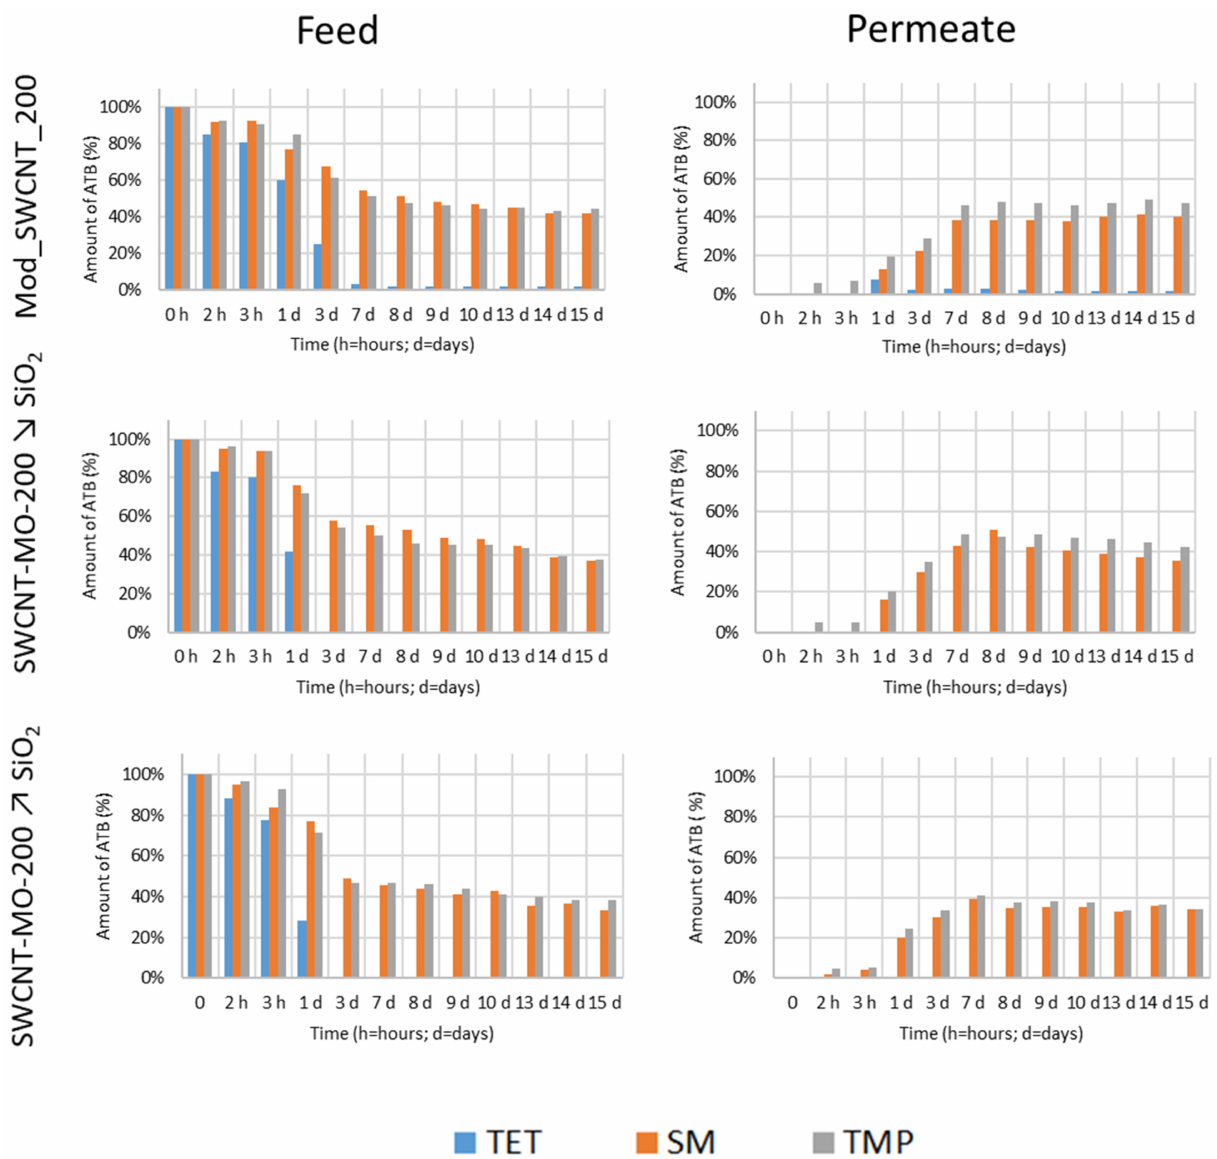
Figure 13. The amount of ATBs (%) in the feed and in the permeate for the modified membranes as a function of